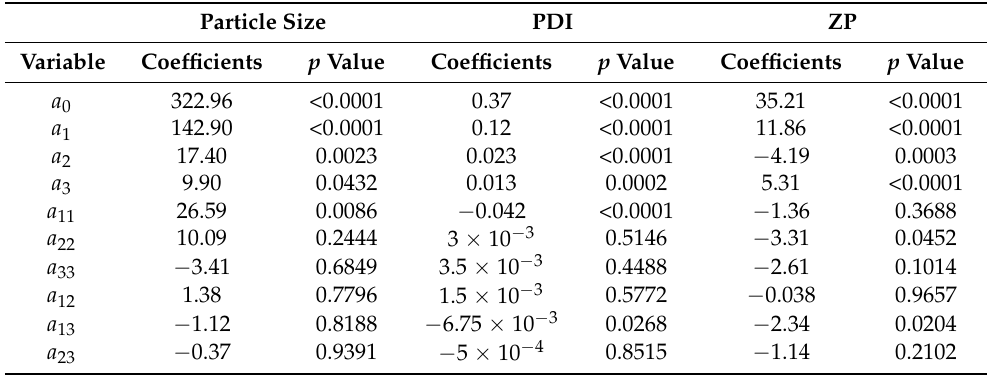
Table 2. Analysis of variance (ANOVA) for the coefficients of the quadratic equation. Particle Size PDI ZP